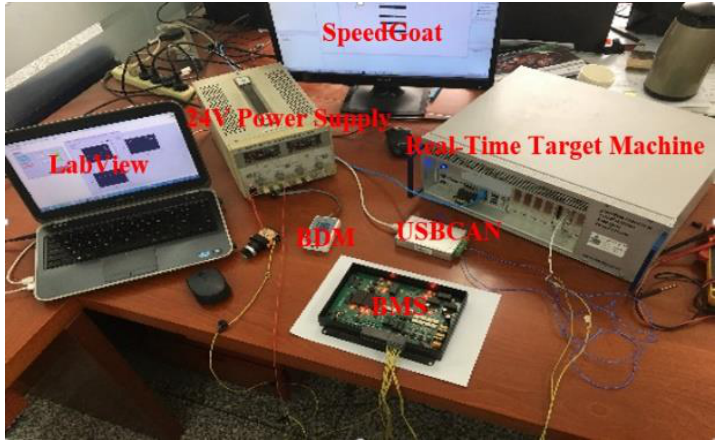
Figure 13. Hardware in the loop test platform.